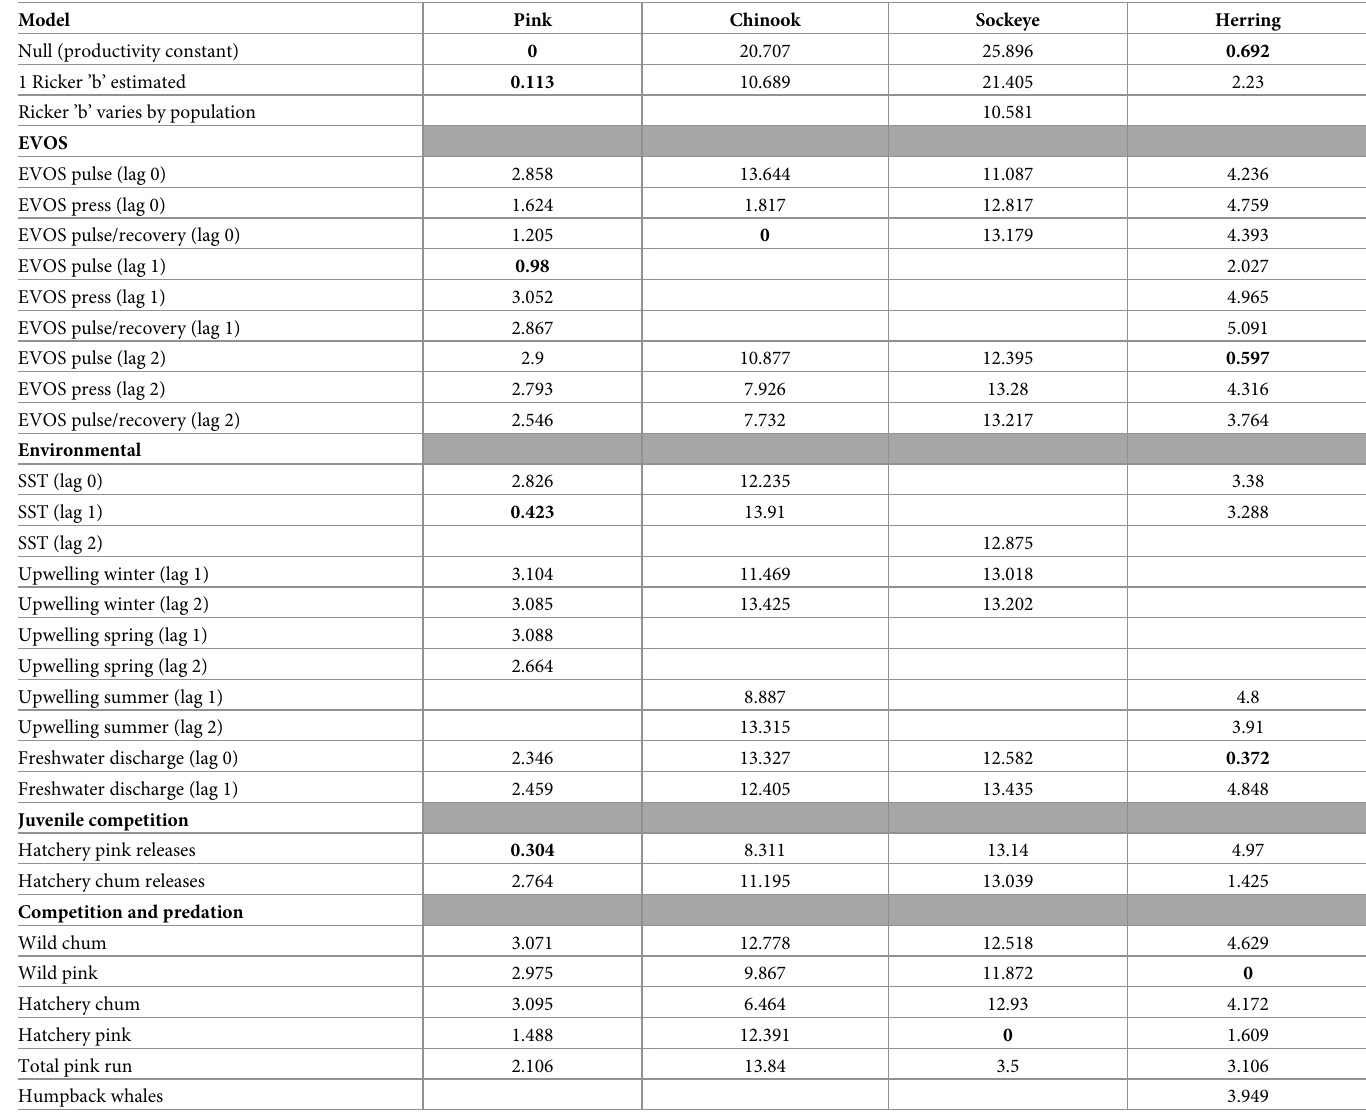
Table 1. Table of delta-AIC values used for model selection (S1–S5 Tables include raw